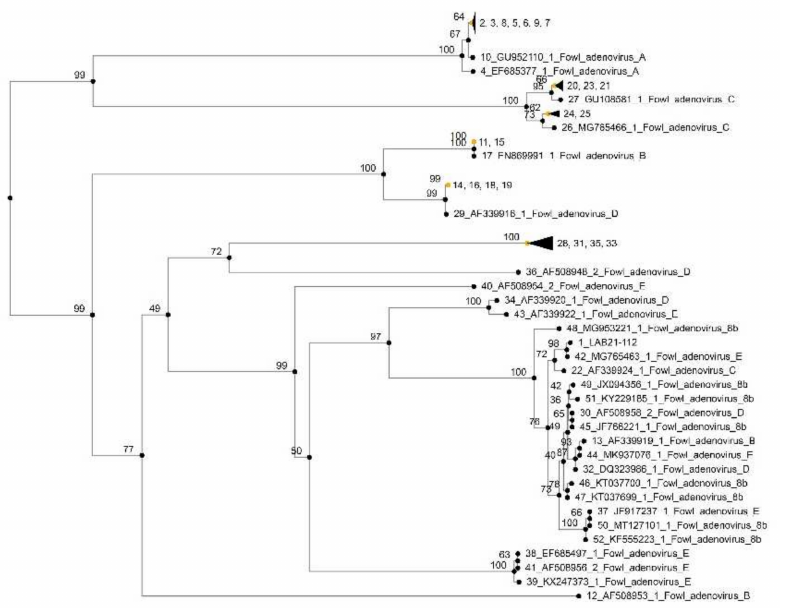
Figure 10. Phylogenetic analysis of the isolated strain (LAB21-112) based on hexon L1. Strain LAB21- 112 was sequenced in this study; the sequences of the other strains were downloaded from GenBank. The phylogenetic tree was generated by MEGA 7.0